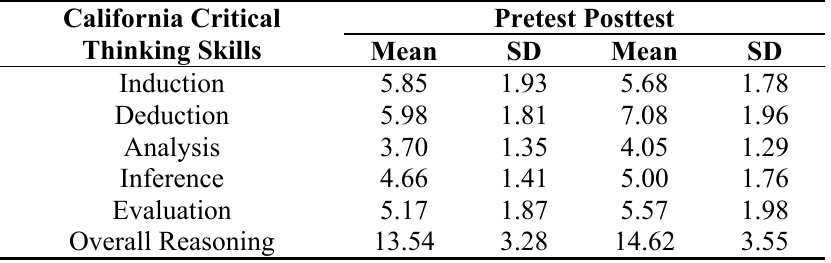
Table 1. Descriptive statistics on pretest-posttests of California critical thinking skills inventory.